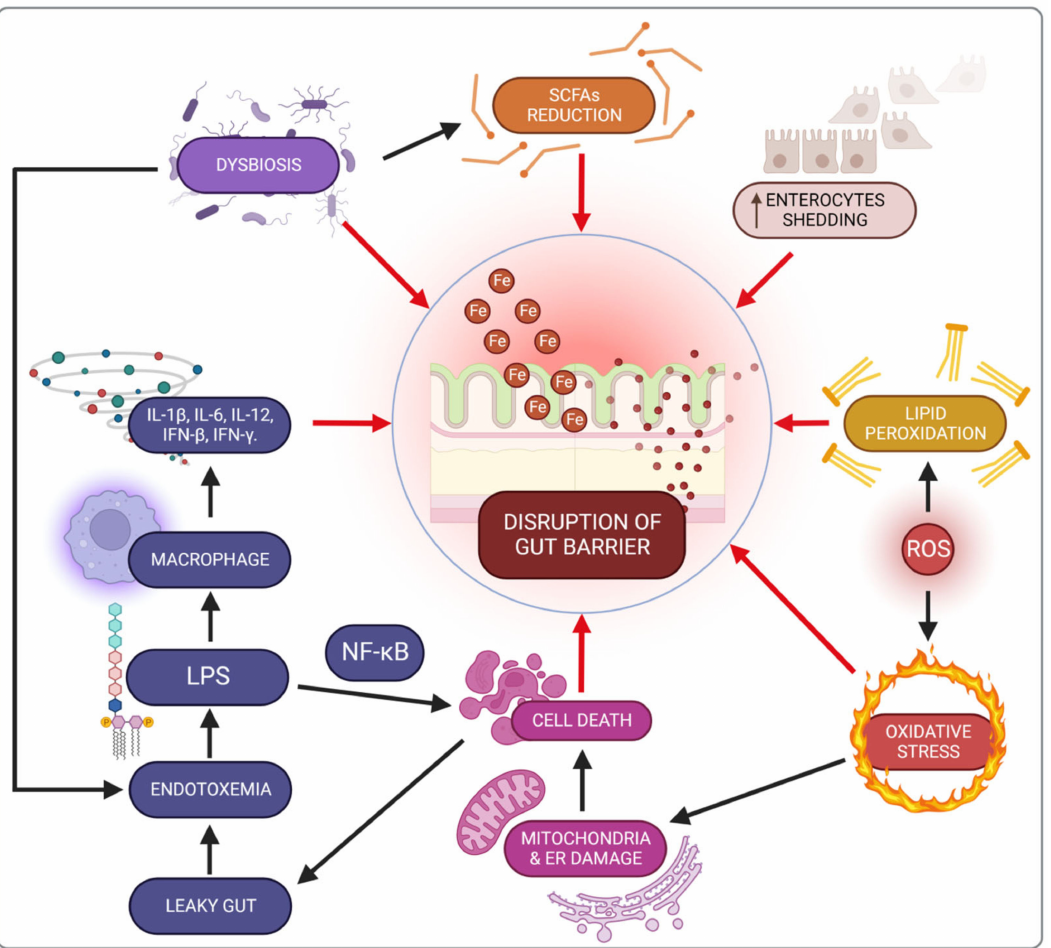
Figure 3. Iron-related gut barrier disruption mechanisms. SCFAs—short-chain fatty acids; IFN- β — interferon β ; IFN- γ —interferon- γ ; IL-1 β —interleukin 1 β ; IL-6—interleukin 6; IL-12—interleukin 12; LPS—lipopolysaccharide; NF-k β —nuclear factor kappa-light-chain-enhancer of activated B cells; ROS—reactive oxygen